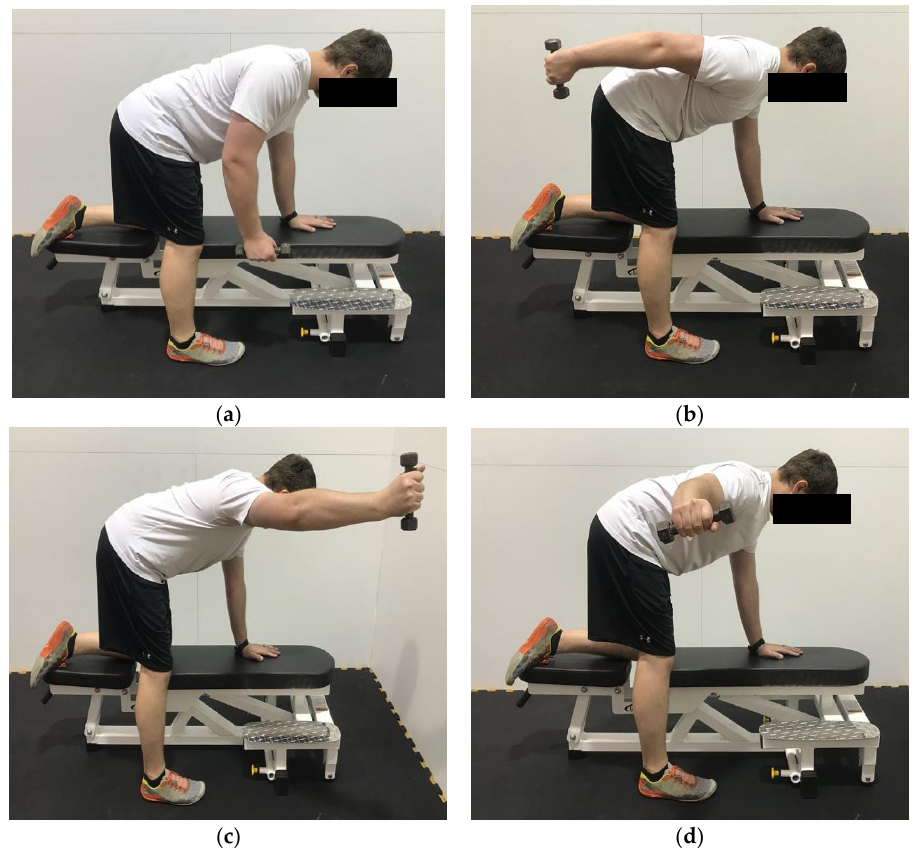
Figure 6. Demonstration of prone shoulder extension, abduction, and horizontal abduction in the ( a ) start position; ( b ) end position for extension; ( c ) end position for abduction; ( d ) end position for horizontal abduction. The goal in performing these exercises is to keep the scapula flush against the rib cage while moving through the various shoulder motions. This shows a modified version, utilizing a bench if a table is not